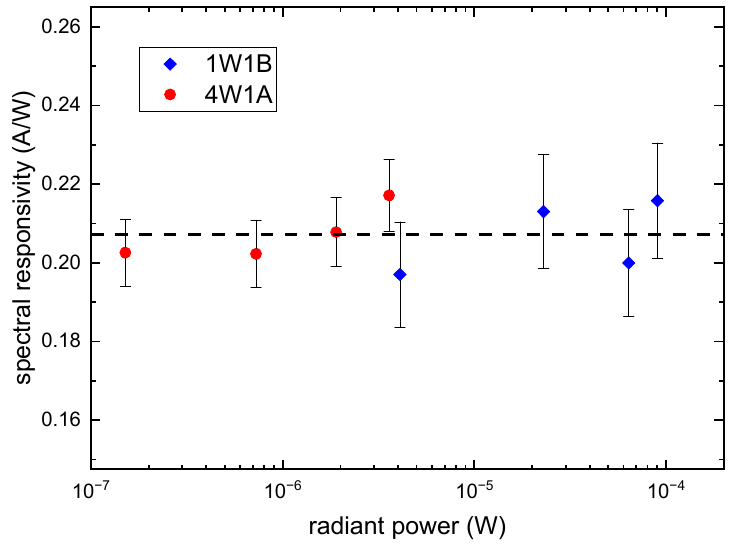
Figure 5. Dependence of the spectral responsivity on the radiant power for the semiconductor photodiode. The dashed line indicates the average spectral responsivity of